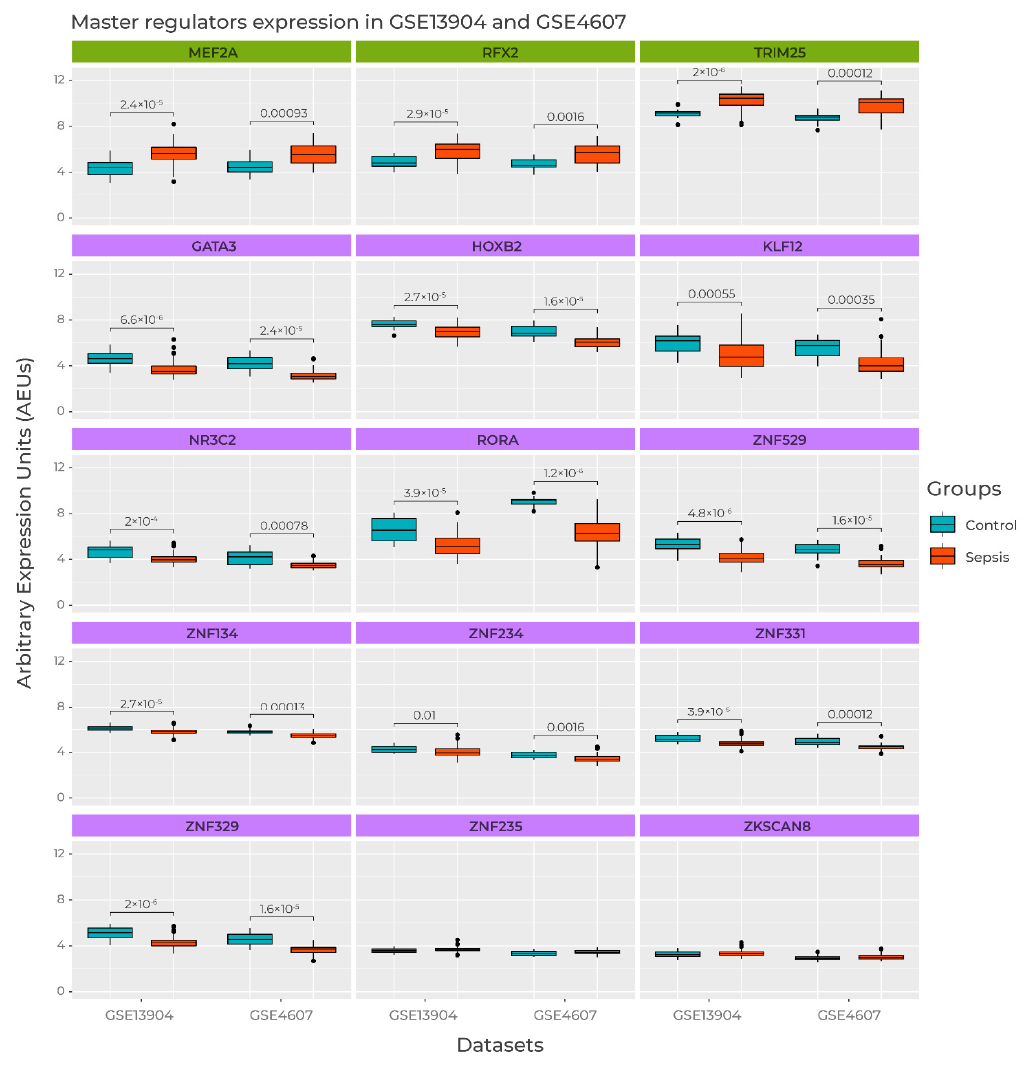
Figure 6. Normalized gene expression of each transcription factor in GSE13904 and GSE4607 datasets. Box heights indicate gene expression in Arbitrary Expression Units; box colors depict septic samples (red), and control samples (blue). An adjusted p -value by Wilcoxon paired test was used. Title color depicts an association with high (green) and low (purple) gene expression in both Pediatric Sepsis 1 and 2 datasets.